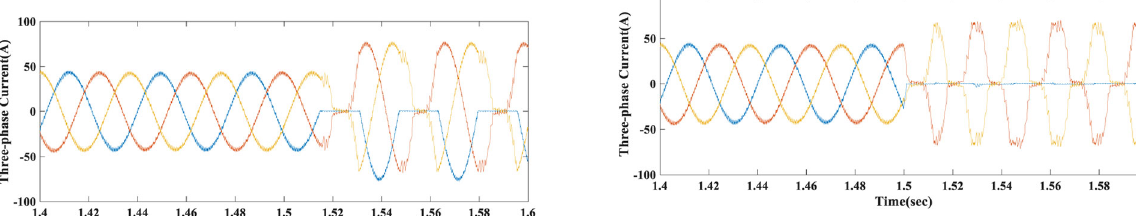
Fig. 4 The waveform when T 1 and T 4 are under open-circuit